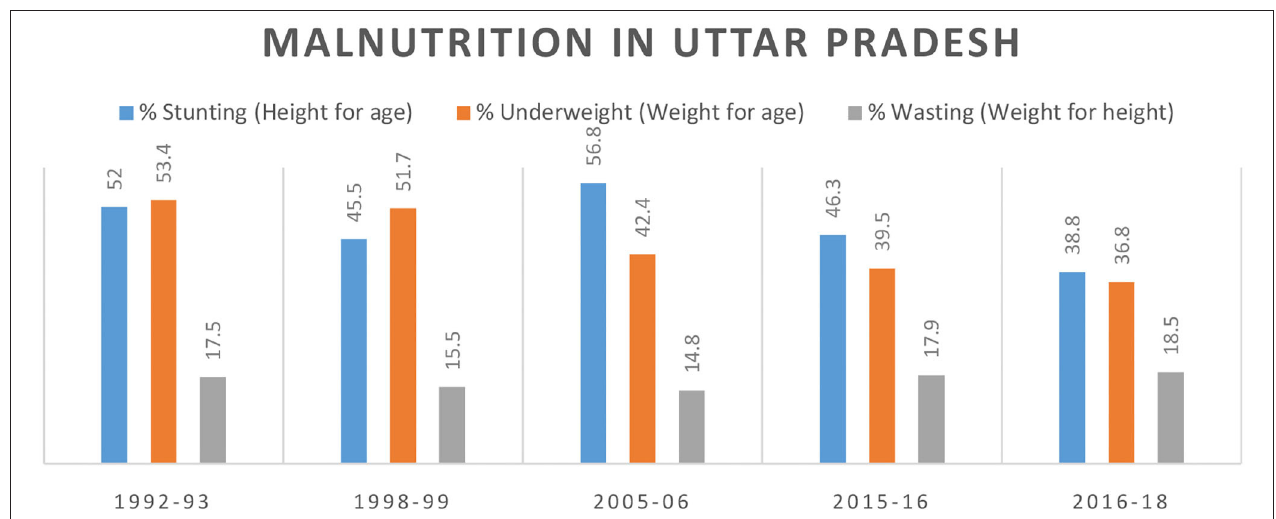
FIGURE 7 | Reduced burden of malnutrition in UP highlights success of interventions implemented for better nutritional status of children.